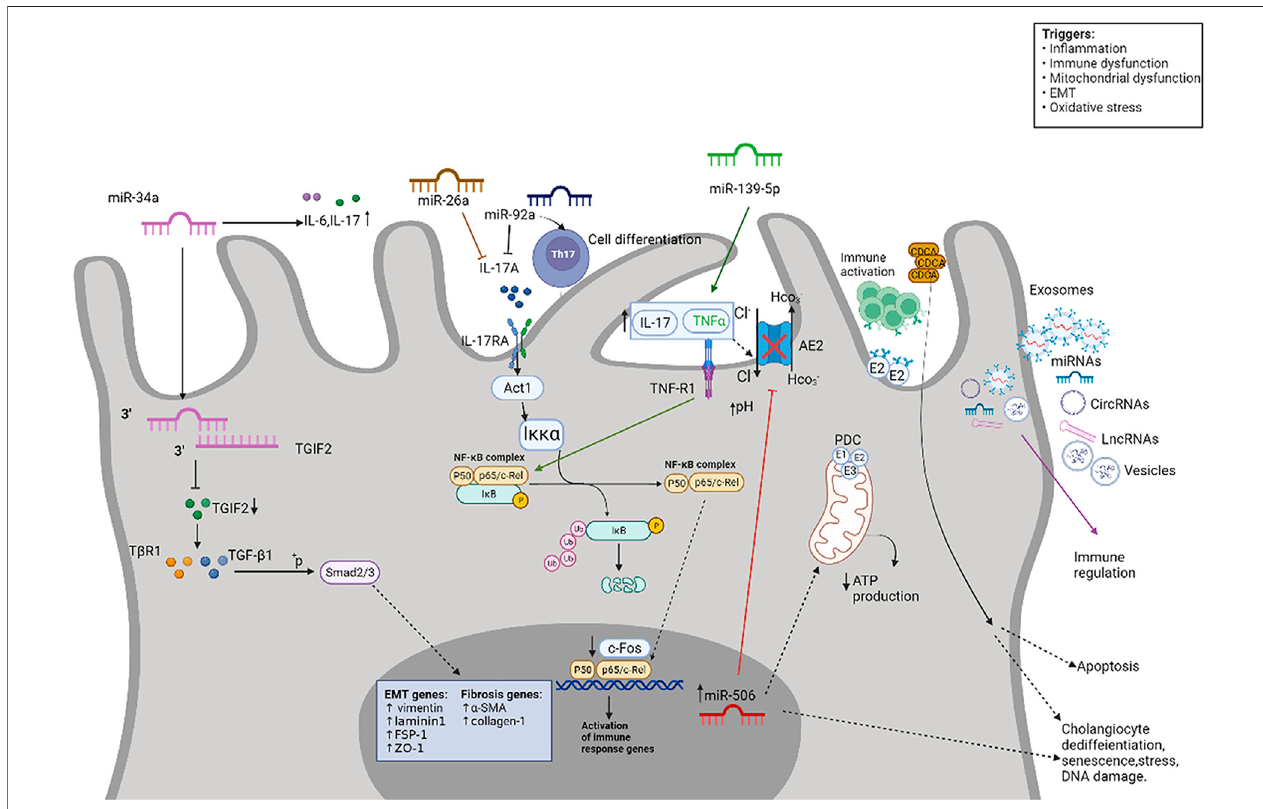
FIGURE 2 | Signaling pathway of miRNAs in PBC. MiRNA are involved in regulating in fl ammation and autoimmunity. Some miRNAs are encapsulated in nanovesicles and exert critical effects on in fl ammatory and immune cells. miRNAs participate in PBC in fl ammation and autoimmune disorders primarily through NF- κ B, TGF- β 1, Th17, and so